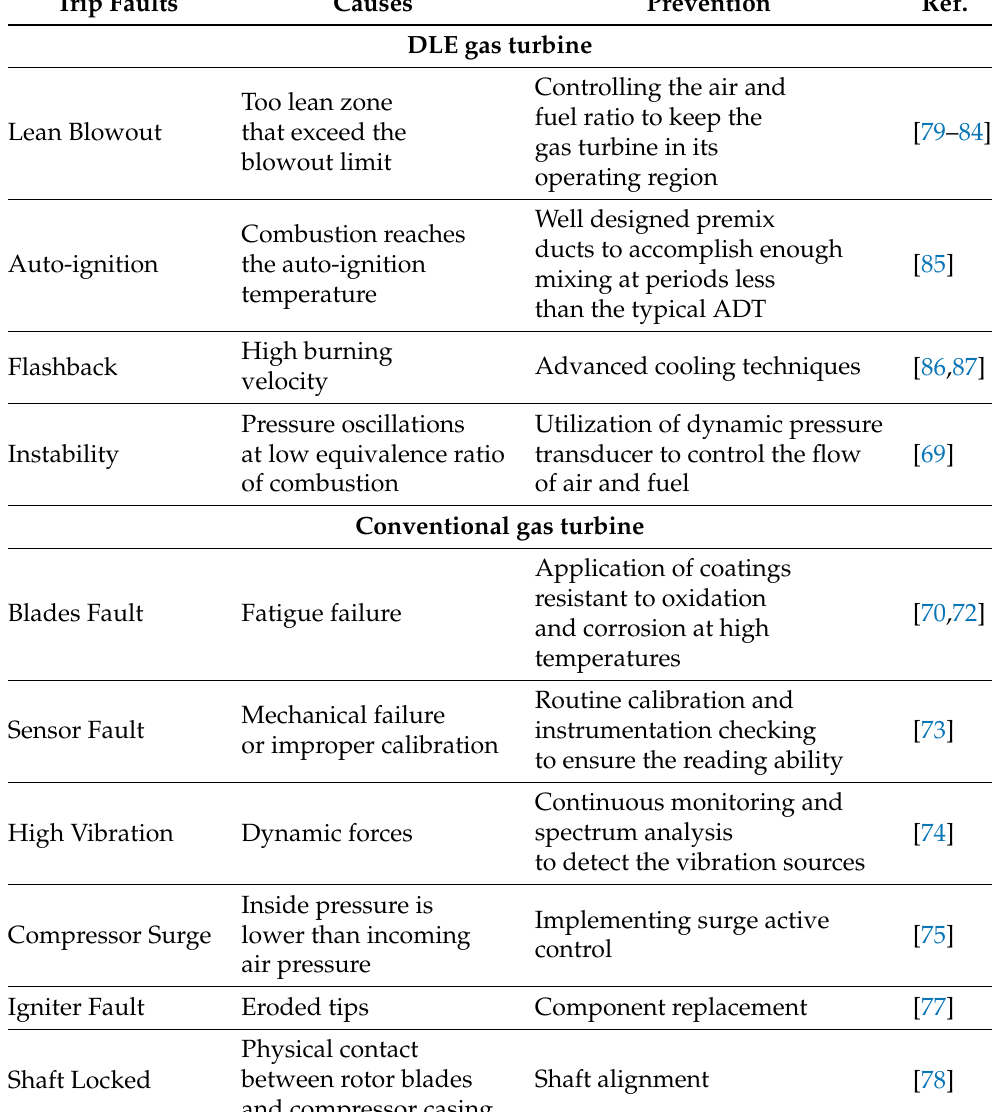
Table 3. Gas Turbine